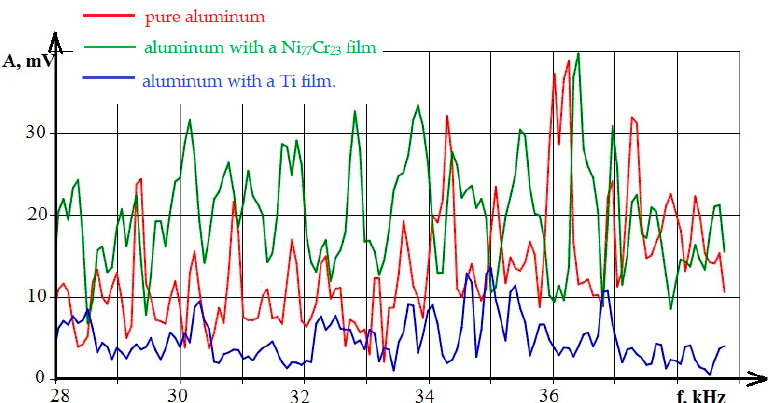
Figure 21. Comparison of the VA signal spectra during electron-beam alloying of an aluminum plate coated with a metal film: (1)—pure aluminum; (2)—aluminum with a NiCr film; (3)—aluminum with a Ti film.